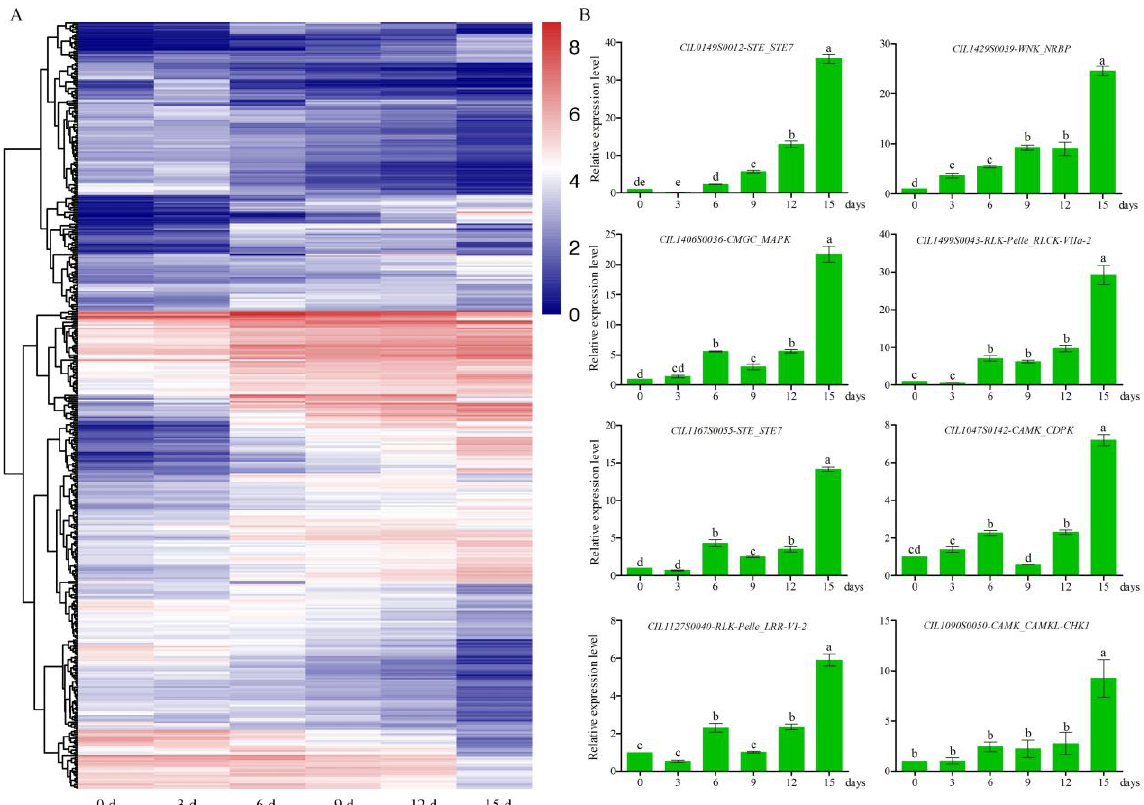
Figure 4. Analysis of the expression of drought-responsive differentially expressed PK genes under drought stress. ( A ) Heatmap for the clustering analyses of differentially expressed PK genes was built based on log 2 (FPKM+1) values. The bar on the right indicates the scale of gene expression levels. ( B ) The validation of the expression levels of selected PK genes in pecans using the qRT-PCR approach. The actin gene was selected as the internal control. Letters represent significant differences according to Duncan’s test ( p < 0.05). Error bars indicate the means ± SEs from three biological replicates. The subcellular localization of a protein can provide insights into its potential func- tion. Based on the expression data, a CAMK_CAMKL-CHK1 gene ( CIL1090S0050 ) was cloned and fused with the GFP (green fluorescent protein) reporter gene. The recom- binant construct was transiently expressed in tobacco, and the result revealed that the CIL1090S0050-GFP fusion protein was detected in both the nucleus and cytoplasm, rep- resenting that the CIL1090S0050 protein was localized to both the nucleus and cytoplasm (Figure